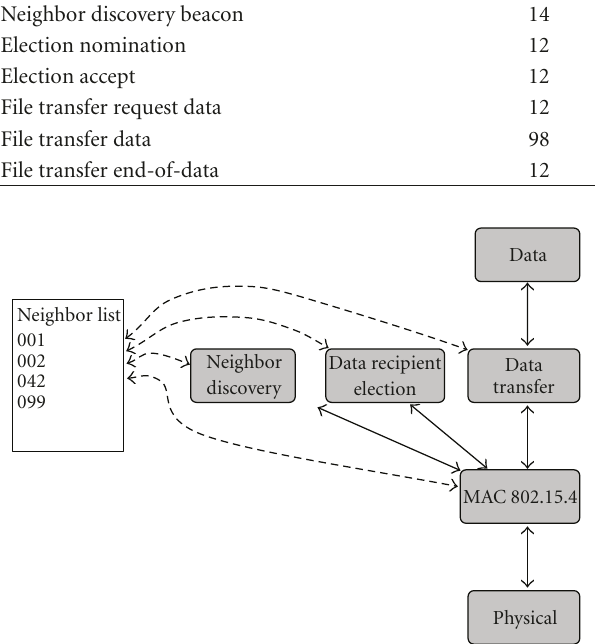
Figure 6: Network stack and associated data structure.